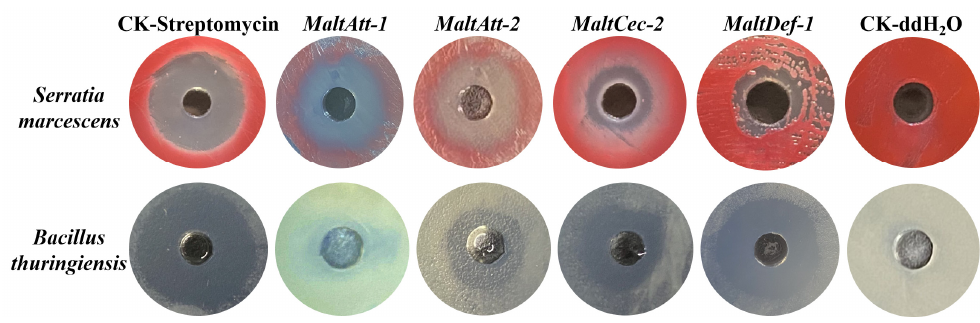
Figure 1. Phylogenetic analysis of M. alternatus AMP genes.